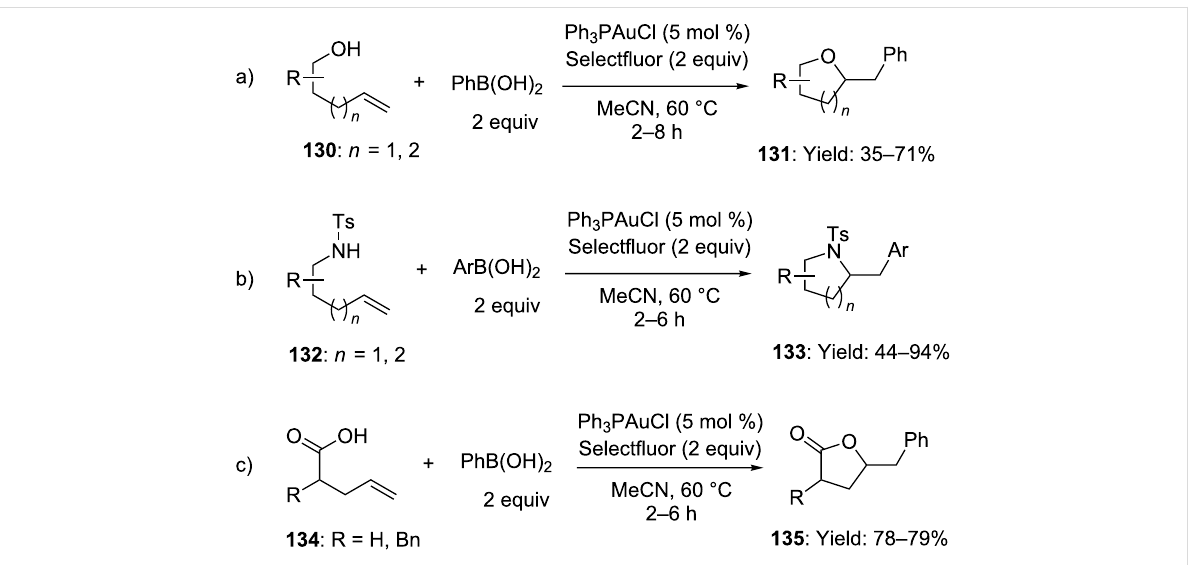
Scheme 33: Gold-catalyzed carboamination, carboalkoxylation and carbolactonization of terminal alkenes with arylboronic